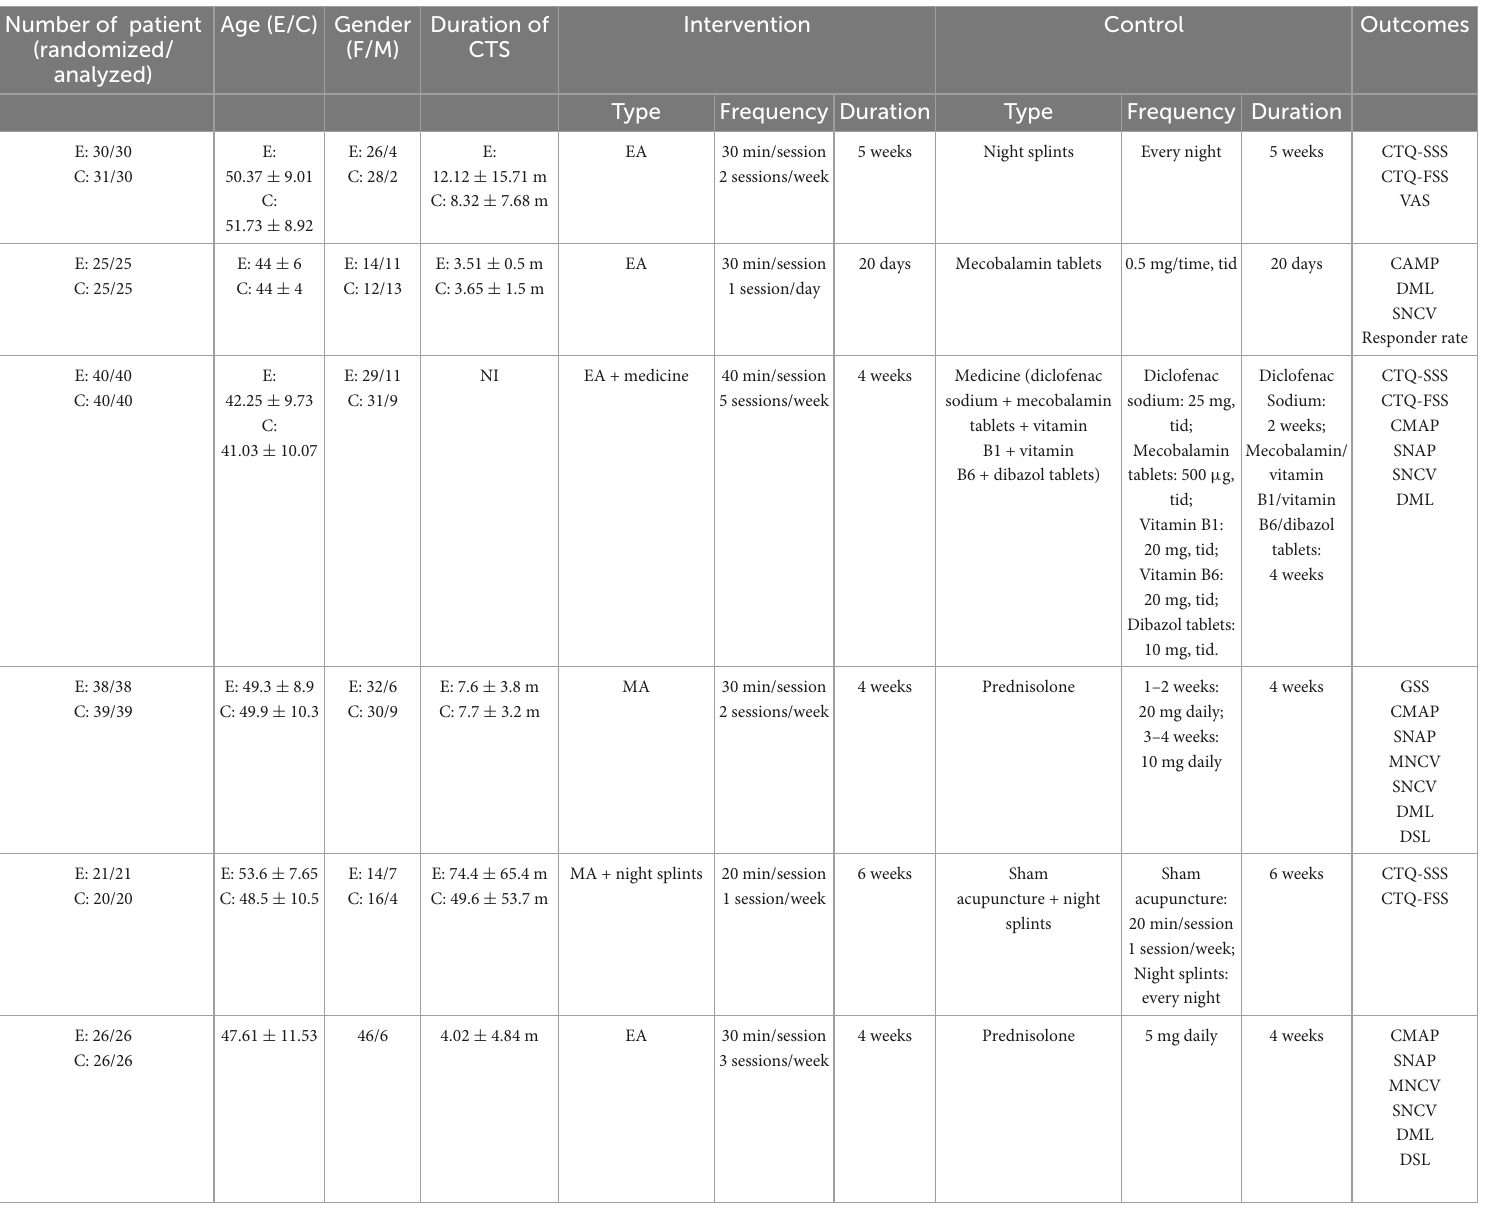
TABLE 1 Characteristics of included